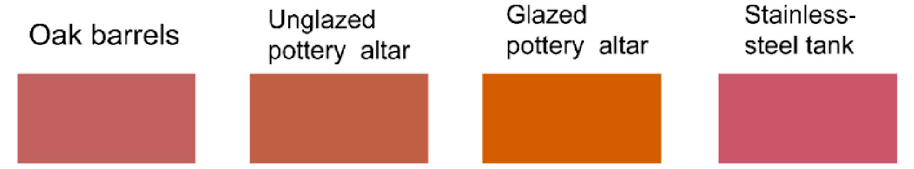
Figure 1. Colors of red wine samples in different aging containers on the 270th day.